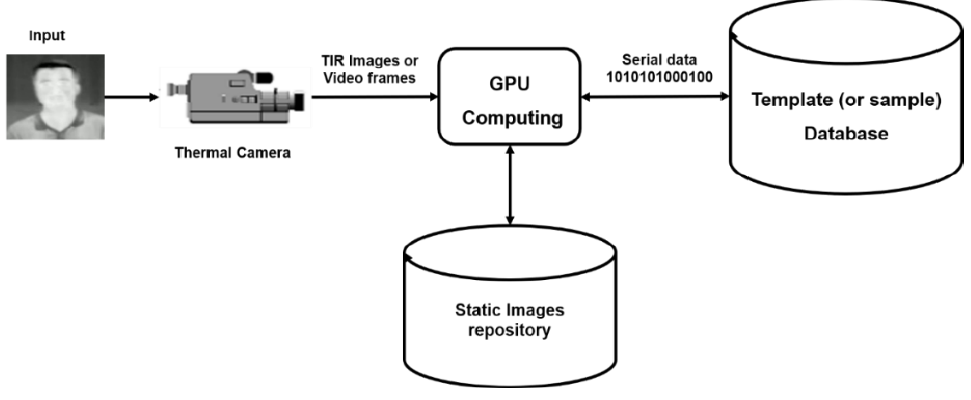
Figure 4. Face recognition